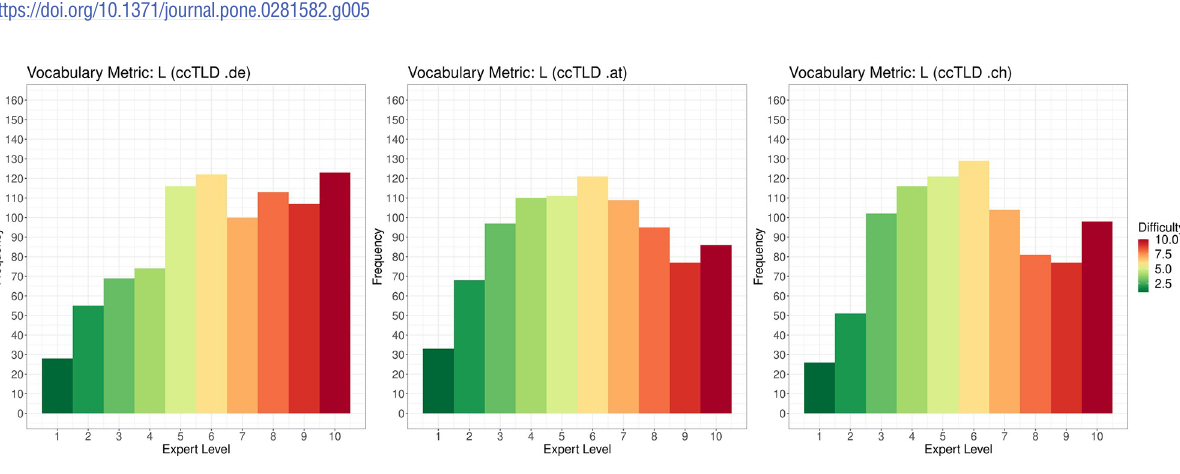
Fig 6. Distribution of achieved vocabulary values on the SVM classification scale L for each ccTLD (“.de”, “.at”, “.ch”). Difficulty is indicated by color with dark green as the most layman friendly (1) and dark red as the highest expert level required (10). SVM: support vector machine.